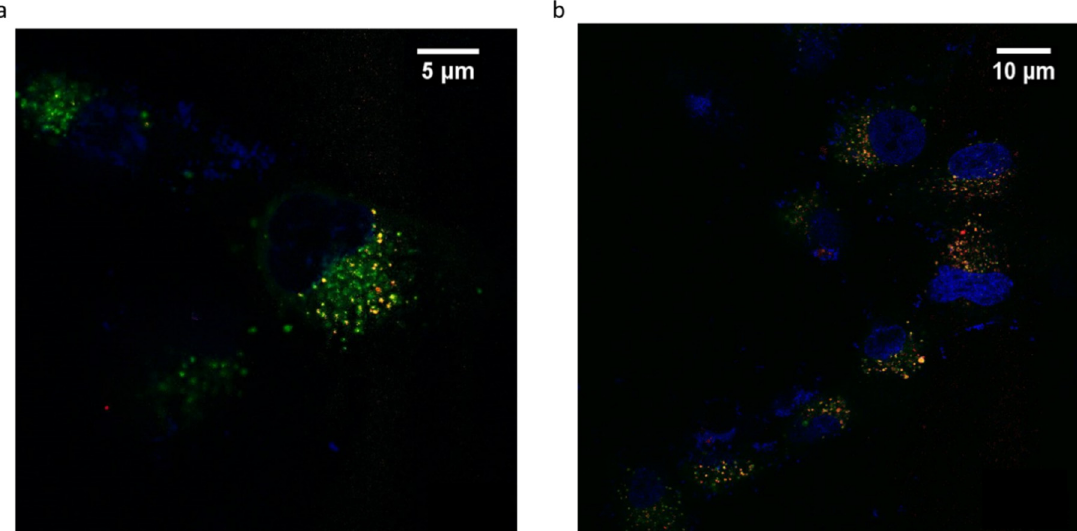
Figure 7. ANG-cHANPs internalization by U87-MG cells at a concentration of 50 µg/mL. ( a ) Time-dependent nanoparticle localization in the cell by confocal microscopy after ( a ) 4 h of incubation; ( b ) 6 h of incubation. Blu: Hoechst 33342, nuclei; Green: Lysotracker Green, lysosomes; Red: ATTO633, ANG-cHANPs.